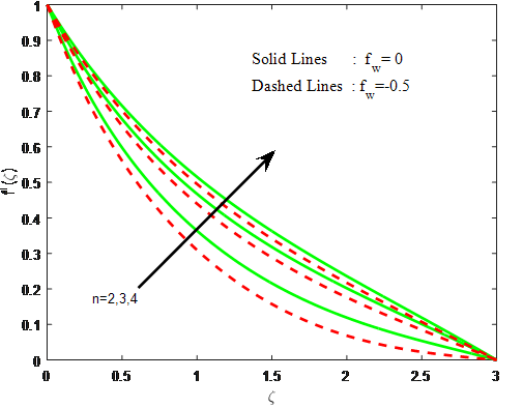
Fig. 12: The effect of Radiation parameter R on temperature field